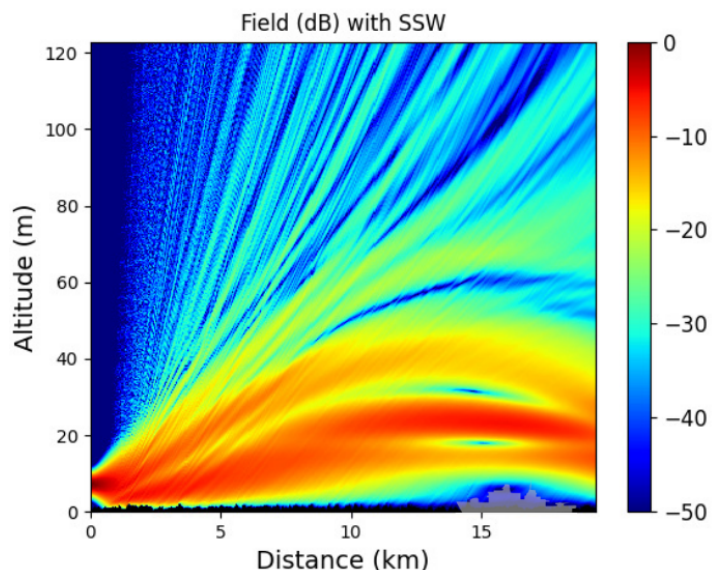
Figure 12. Mean reduced field over 50 Monte-Carlo simulations computed with the SSW method. In this case the source is placed z s = 5 m above the